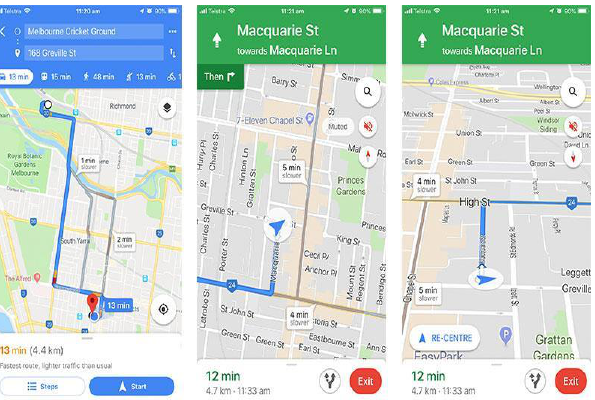
Figure 5. Routing and navigation with Google maps.